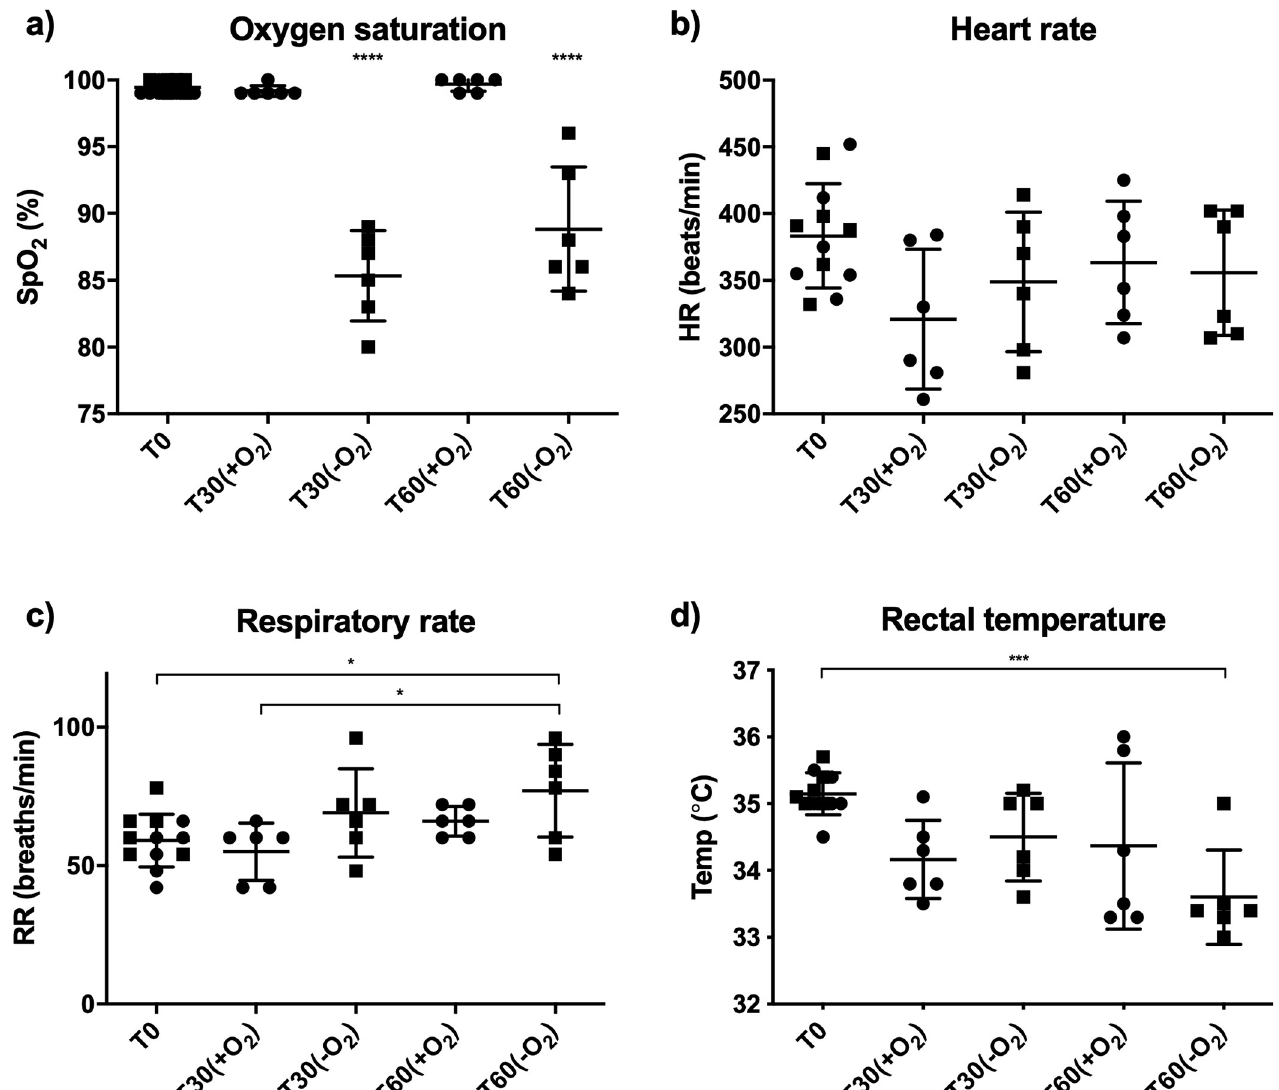
Fig 1. Vital signs with oxygen saturation (a), heart rate (b), respiratory rate (c) and rectal temperature (d) of rats after surgery under fentanyl/fluanisone and midazolam anaesthesia. T0 represents measurements immediately after surgery. Measurements 30 and 60 minutes after surgery are indicated by T30 or T60 respectively. Oxygen supply is indicated by +O 2 (with oxygen supply) and -O 2 (without oxygen supply). Symbol shape indicates +O 2 group for circle and -O 2 group for square. In (a) ���� indicates p < 0.0001 for T30(-O 2 ) and T60(-O 2 ) versus all other measure points. In (c) � indicates p < 0.05 for T0 versus T60(-O 2 ) and T30(+O 2 ) versus T60(-O 2 ), and in (d) ��� indicates p < 0.001 for T0 versus T60(-O 2 ). HR: Heart rate, RR: Respiratory rate, Temp: Temperature. Values are means ± standard deviations.